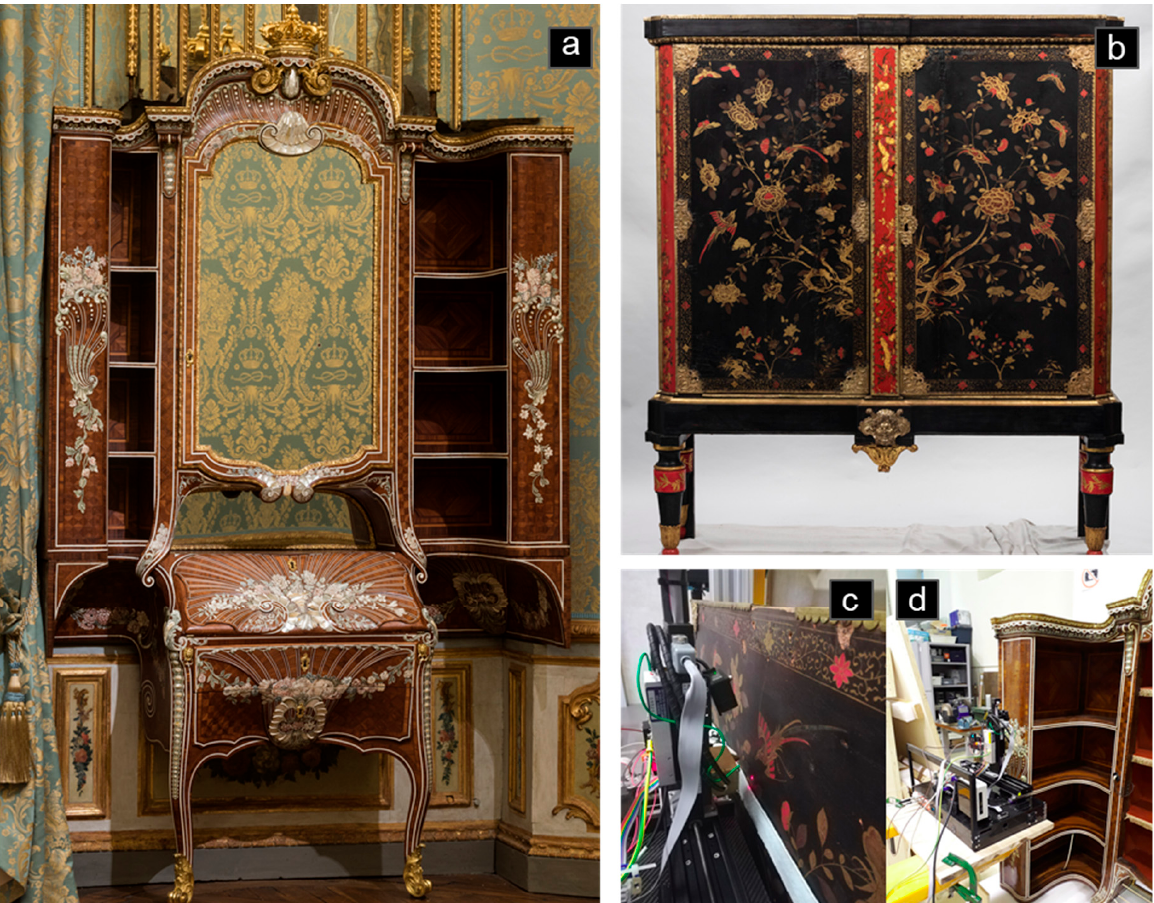
Figure 1. Pictures of the furniture and of the Cultural Heritage Network of the National Institute of Nuclear Physics (INFN-CHNet) macro X-ray fluorescence (MA-XRF) scanner during the measurements: ( a ) Writing desk Scrivania con scansia by Pietro Piffetti; ( b ) Chinoiserie wooden cabinet; ( c ) Scanner placed in front of the chinoiserie wooden cabinet; and ( d ) in front of the external side of the scansia.